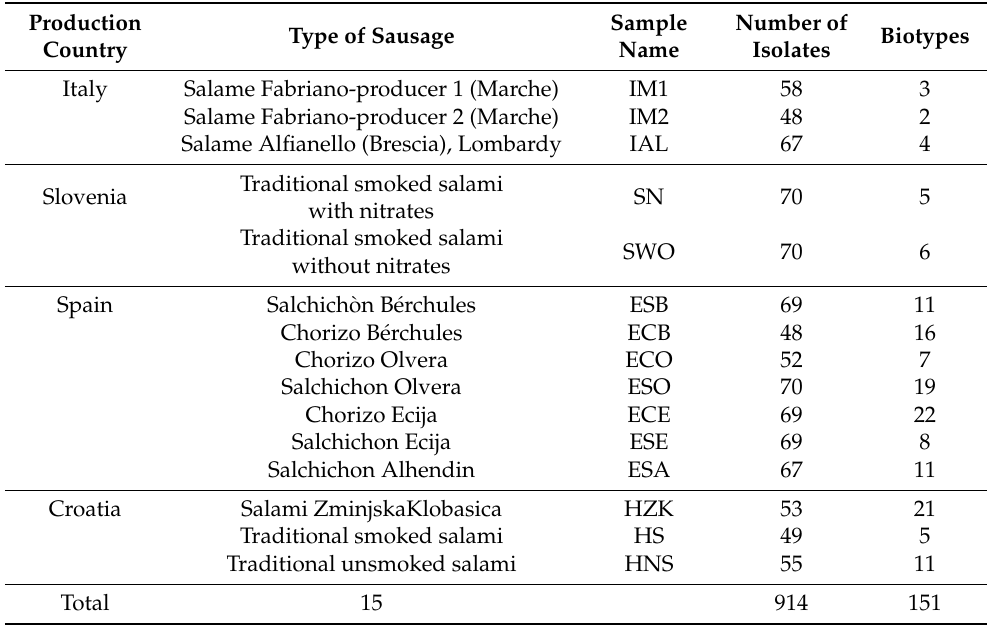
Table 2. Type of sausages, number of isolates and biotypes from the four different production countries (Italy, Slovenia, Spain and